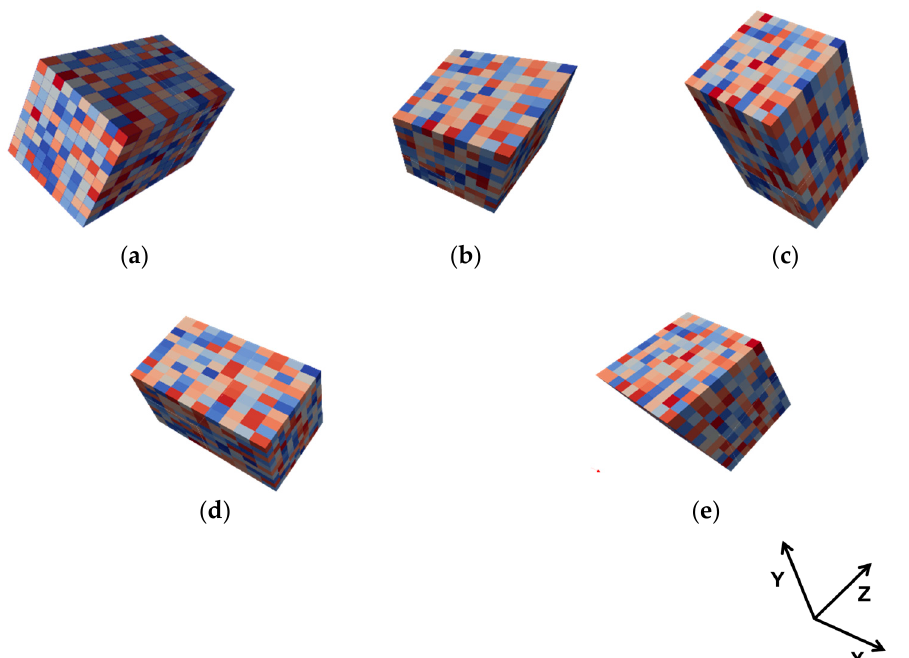
Figure 6. Deformed RVEs representing the effect of a rotating load frame in different directions: ( a ) x is rotated at 90 degrees; ( b ) x and y are rotated at 45 degrees; ( c ) x and y are rotated at 90 degrees; ( d ) without any rotation or load frame; and ( e ) x, y and z are rotated at 45 degrees (reprinted with permission from [44], Carl Hanser Verlag, 2020). The simulations were run on all the generated RVEs using the material model from Wong et al. and Manjunatha et al. [37,38]. Detailed material model attributes for the TRIP/TWIP steels are provided in Appendix A.2. All the simulations were run for a total of a 33% strain in 4850 increments. Please read the work of Qayyum et al. for further details about this work [44].